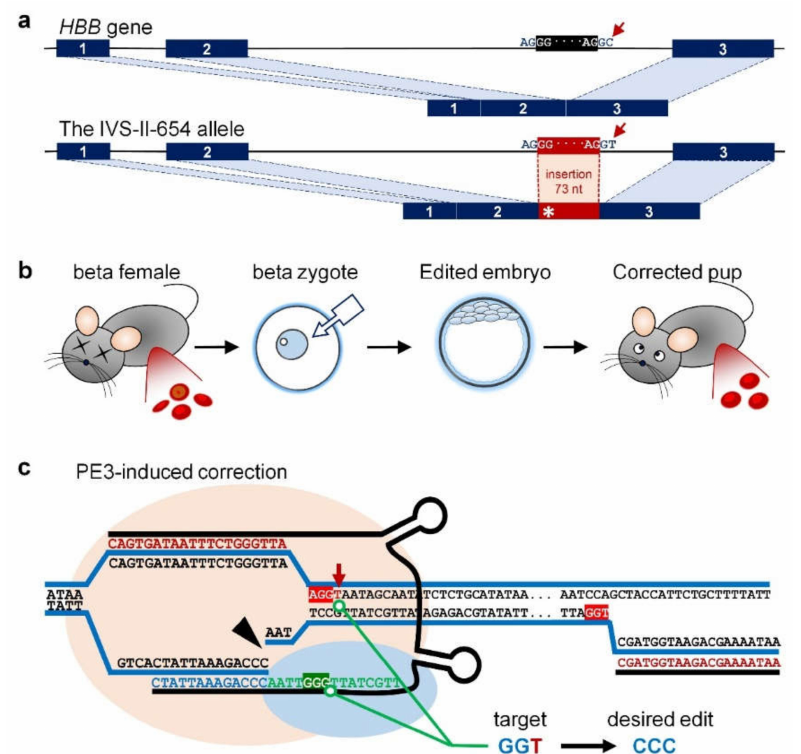
Figure 1. Study scheme. ( a ) Molecular mechanism of IVS-II-654 (C > T) mutation in the HBB gene. The IVS-II-654 mutation causes abnormal splicing, and a partial second intron sequence with a length of 73 nucleotides (nt) is thus spliced into the HBB mRNA, leading to a premature stop codon [4–6]. The asterisk indicates the premature stop codon generated by the insertion of 73-nt sequence. ( b ) Study workflow. Hbb th − 4 / Hbb + (beta) mice carrying the IVS-II-654 mutation showed classic signs of beta- thalassemia, including anisocytosis and target cells in the peripheral blood. The in vitro transcripts of PE2, prime editing guide RNA (pegRNA), and nick sgRNA required for prime editor 3 (PE3) were microinjected into zygotes from beta mice. The injected zygotes developed into edited embryos, and subsequently into pups, with the corrected IVS-II-654 mutation. Beta-thalassemia symptoms in the peripheral blood were resolved by PE3-induced treatment. ( c ) PE3 used for correcting IVS-II-654 mutation in this study. The endogenous DNA sequence is shown in black. The pegRNA contained a spacer sequence and was designed to target the IVS-II-654 site (red letters). The prime binding sequence (PBS, blue letters) of pegRNA was designed to hybridize with the 3 (cid:48) end of the nicked target DNA strand to form a primer-template complex. Moreover, the reverse transcriptase (RT) template (green letters) of pegRNA was designed to install a therapeutic GGT > CCC conversion at the IVS-II-654 site, which corrects the beta-thalassemia mutation and edits the SpCas9 protospacer adjacent motif (PAM) region to prevent secondary editing. The nick sgRNA (red letters in the right area) was designed to target the non-edited strand, 99-nt downstream away from the nicking position of pegRNA, for further increasing editing efficiency. Red highlight marks the PAM area; red arrow indicates the IVS-II-654 (C > T) mutation; green highlight illustrates therapeutic RT-template converting GGT to CCC. The pink shade and blue shade indicate the nCas9 domain and RT domain of PE protein, respectively. The black arrowhead indicates the nCas9 of PE protein-induced nicking position, 3-nt upstream from the PAM